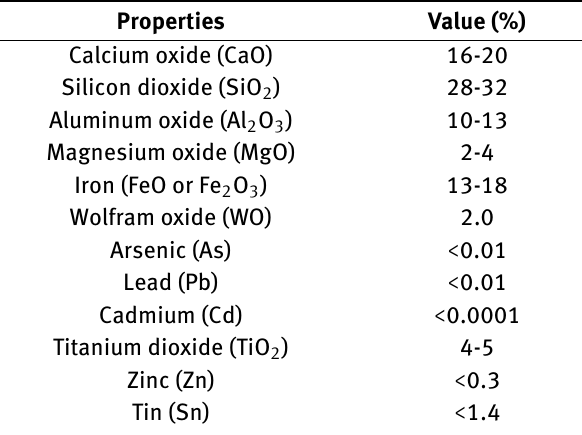
Table 1: Chemical composition of tin-slag [14, 15]